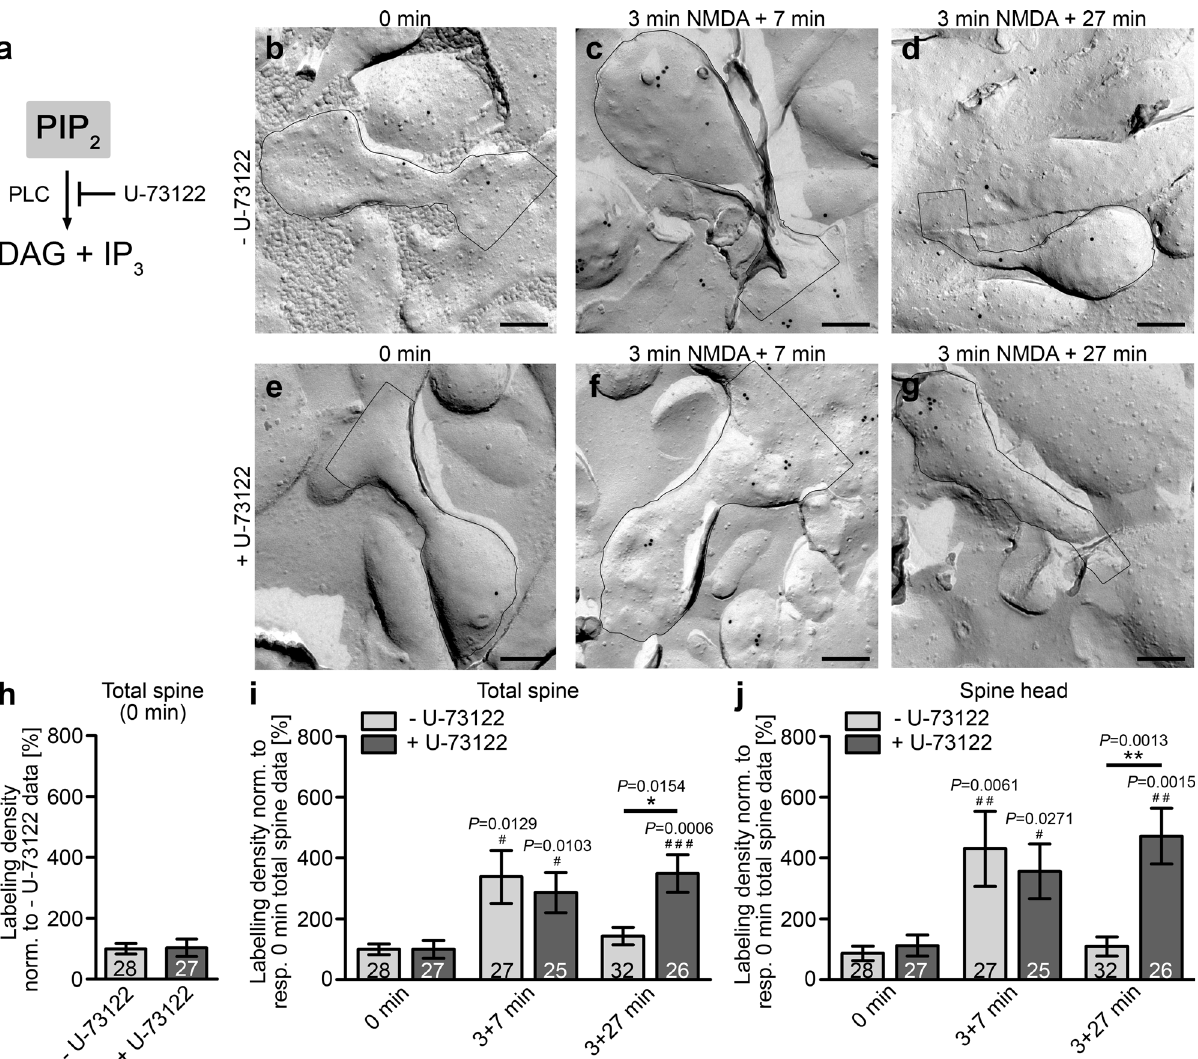
PIP 2 yielding DAG + IP 3 and the inhibition by the PLC inhibitor U-73122. b – g TEM images of dendritic spines of anti-PIP 2 immunolabeled, freeze-fractured spines of DIV14-16 hippocampal neurons, which were merely pretreated with vehicle control (0.2% DMSO) ( − U-73122, b – d ) or with 10 µ M U-73122 ( e – g ) prior to either inducing LTD by 3 min NMDA and 7 min recovery time (3 + 7 min) and by 3 min NMDA and 27 min recovery time (3 + 27 min), respectively, or leaving the cells at steady state (0 min). Bars, 200 nm. h Quantitative analyses of the anti-PIP 2 labeling density of + U-72122 and − U- 73122 neurons at steady state normalized to the respective untreated control. ( i , j ) Quantitative analyses of PIP 2 dynamics demonstrating that PLC inhibition has no effect on PIP 2 levels during the second phase (3 + 7 min) of LTD induction but completely blocks the restauration of steady-state PIP 2 levels during the third phase (3 + 27 min) of PIP 2 dynamics during LTD induction. Data, mean ± SEM. − U-73122, 0 min, n = 28; 3 + 7 min, n = 27; 3 + 27 min, n = 32 ROIs each (total spines; spine heads) and + U-73122, 0 min, n = 27; 3 + 7 min, n = 25; 3 + 27 min, n = 26 ROIs each (total spines;